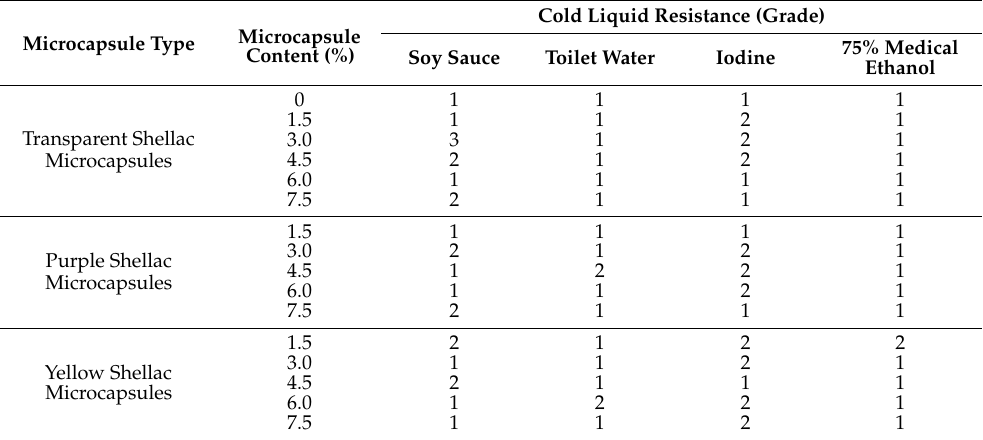
Table 10. The cold liquid resistance of coating on Beli wood with the content of different shellac microcapsules in the coating.